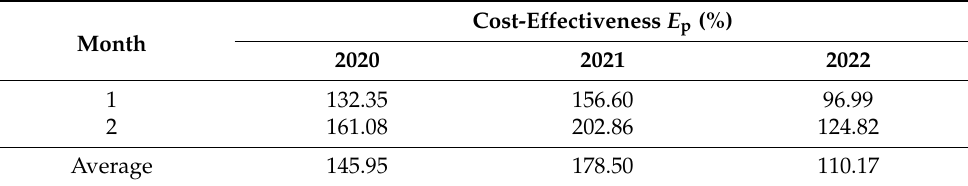
Table 15. Results of producing semi-finished furniture elements according to the variant “Ap”.